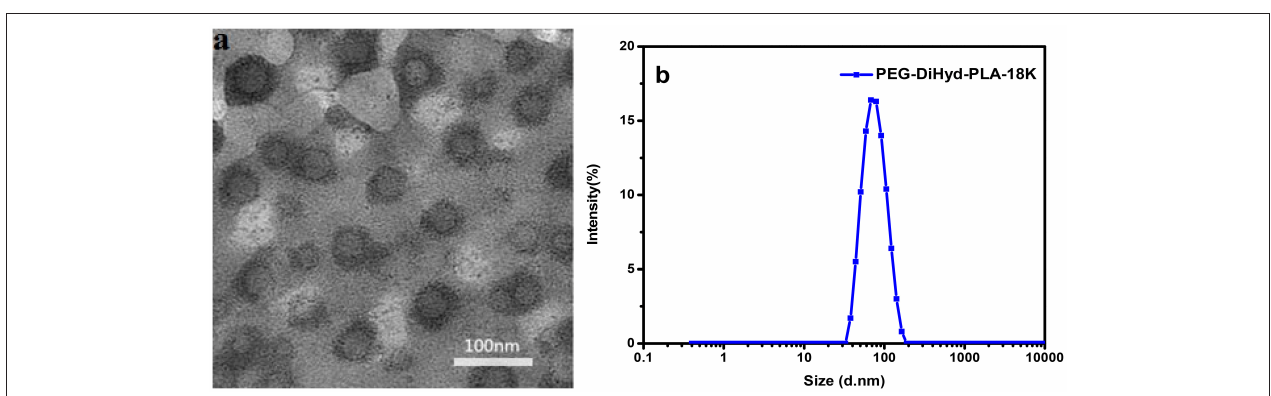
FIGURE 4 | Images of micelles formed by PEG-DiHz-PLA-18K (a) . The particle size of PEG-DiHyd-PLA-18K micelles (b) .